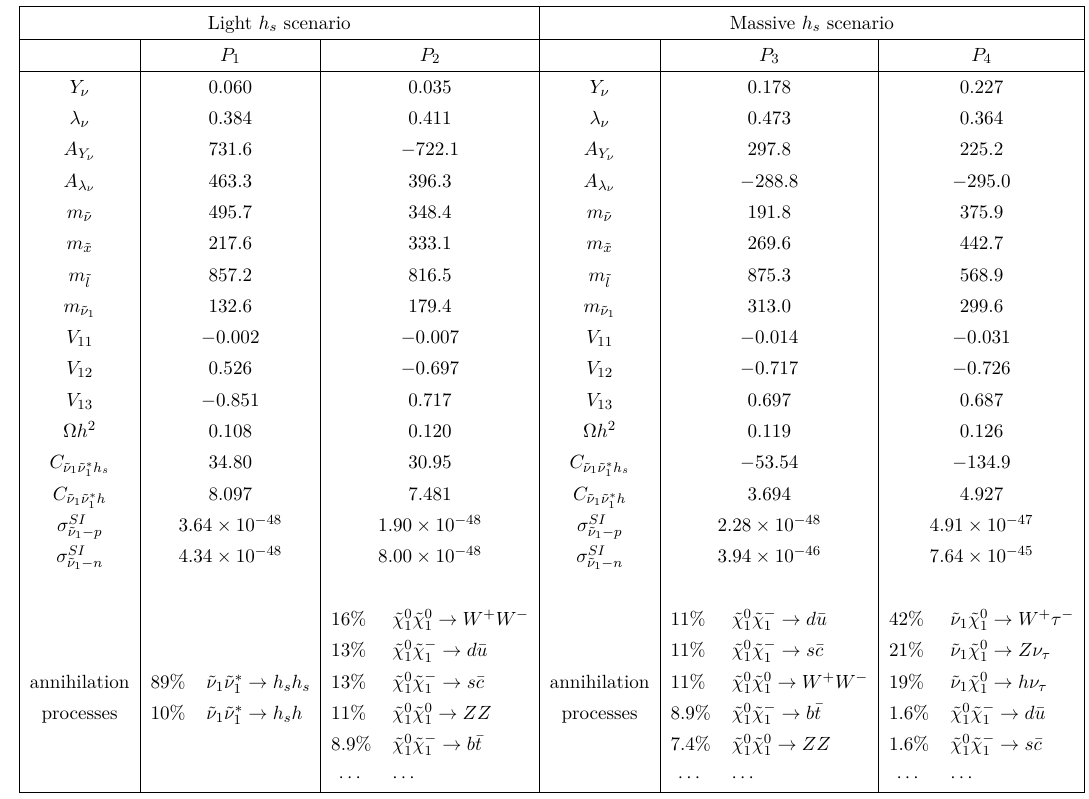
Table 2 . Detailed information of the points in the light h s scenario (left side of the table) and the massive h scenario (right side of the table) with the setting B s annihilation process represents the fraction of its contribution to the total DM annihilation cross section at the freeze-out temperature. Parameters in mass dimension are in unit of GeV, and the DM-nucleon scattering cross section are in unit of cm 2